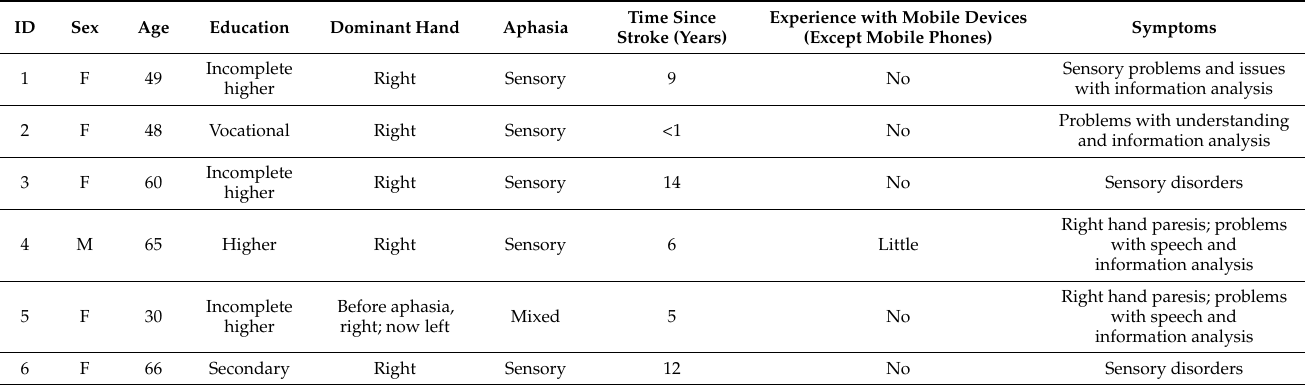
Table 1. Usability test